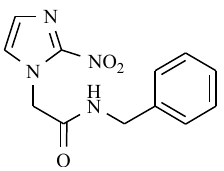
Table 3. 5-Nitrofuran analogues with antibacterial activity. O RO 2 N Compound R 1